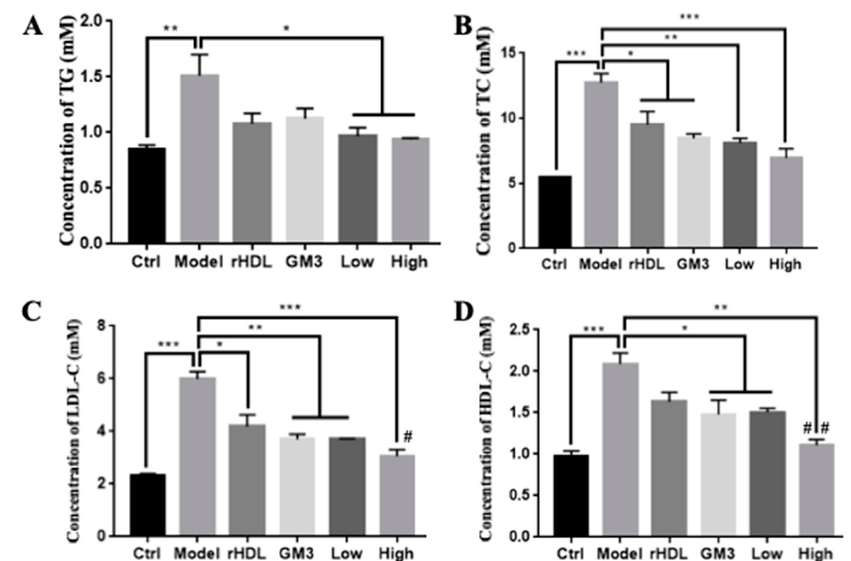
Figure 5. Inhibitory effects of GM3-rHDL nanoparticles on the high fat diet-induced increases in concentrations of main blood lipids in ApoE − / − mice. The mice were fed a chow diet (ctrl) for eight weeks or a high-fat diet in combination with no treatments (model) or with a treatment (once every three days) of rHDL, ganglioside GM3 (1.2 mg/kg), GM3 L -rHDL nanoparticles (0.2 mg/kg GM3), or GM3 H -rHDL nanoparticles (1.2 mg/kg GM3), respectively for eight weeks. ( A ) Triglyceride (TG). ( B ) Total cholesterol (TC). ( C ) LDL-cholesterol (LDL-C). ( D ) HDL-cholesterol (HDL-C). * p < 0.05, ** p < 0.01, *** p < 0.001 ( n = 6) compared with the control or with the model; # p < 0.05, ## p < 0.01 ( n = 6) compared with the GM3 group.